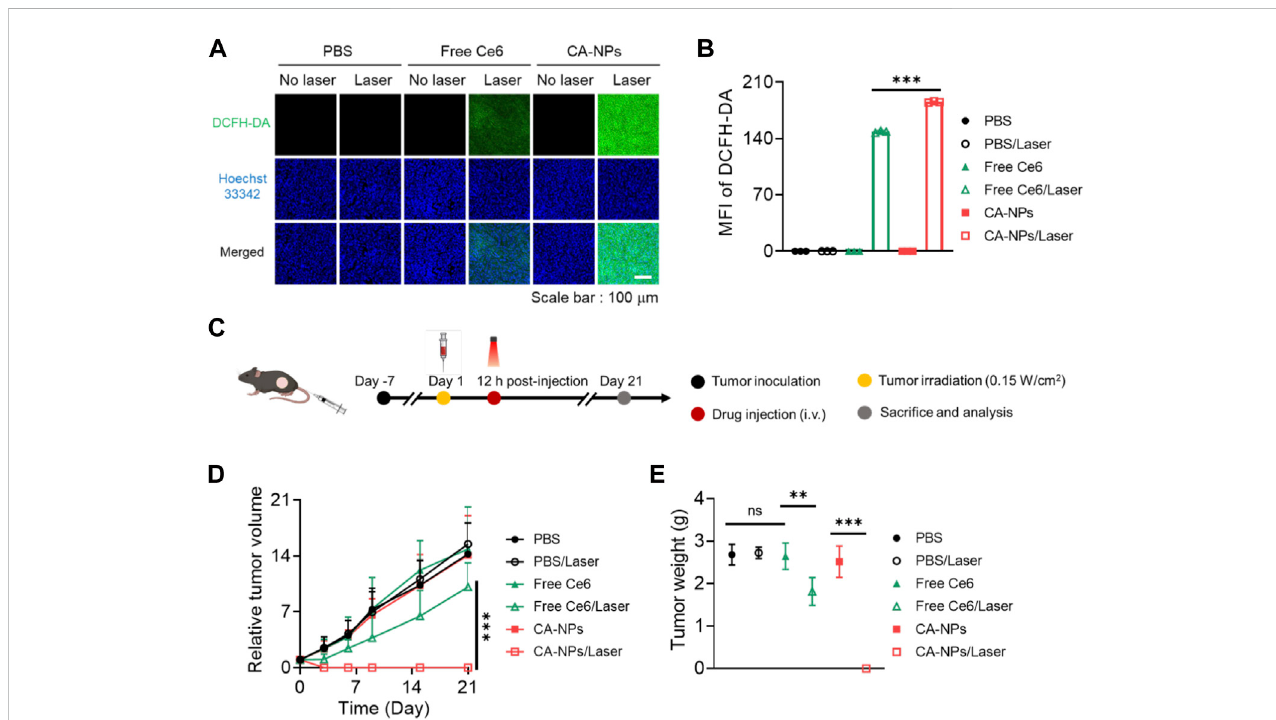
FIGURE 5 Invivo anti-tumoreffectofCA-NPs. (A,B) Confocalimagesand fl uorescenceintensitiesoftheMB49tumorfromthemicetreatedwithPBS,FreeCe6and CA-NPs at the dose of 5.0 mg/kg under irradiation or not (0.15 W/cm 2 , 5min) and stained with DCFH-DA. Scale bar: 100 μ m. (C) . Schematic illustration of therapeutic procedure of CA-NPs. (D,E) Tumor growth pro fi les and corresponding tumor mass (day 21) of the mice bearing MB49 tumors treated with PBS, Free Ce6 and CA-NPs at the dose of 5.0 mg/kg Ce6 under irradiation or not (660 nm, 0.15 W/cm 2 , 5 min). (n = 7; ns: no signi fi cance, ** p < 0.01, *** p <